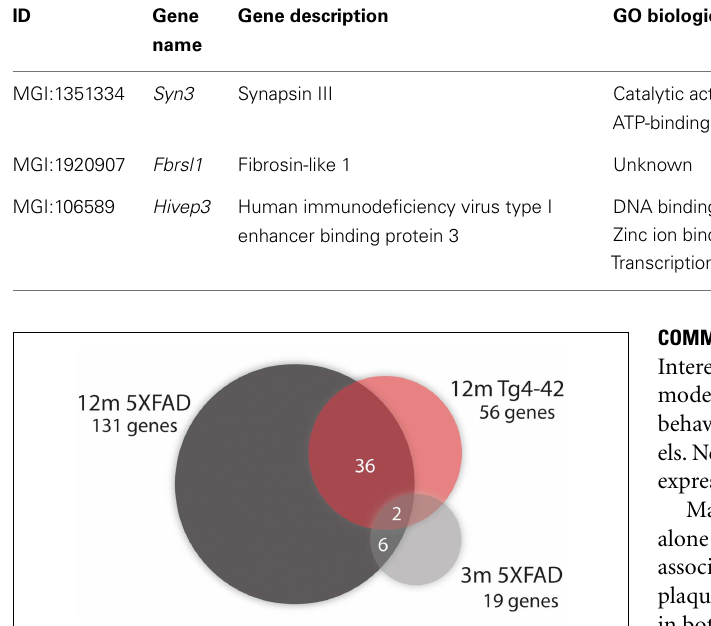
FIGURE 6 |Venn diagram analysis for significantly regulated genes in Tg4–42 mice compared to 5XFAD mice .The numbers outside each circle represent the number of genes that were significantly differentially expressed in the respective mouse line (compared toWT mice).The numbers in the spaces of overlapping circles represent the number of genes that were affected in more than one condition. p <